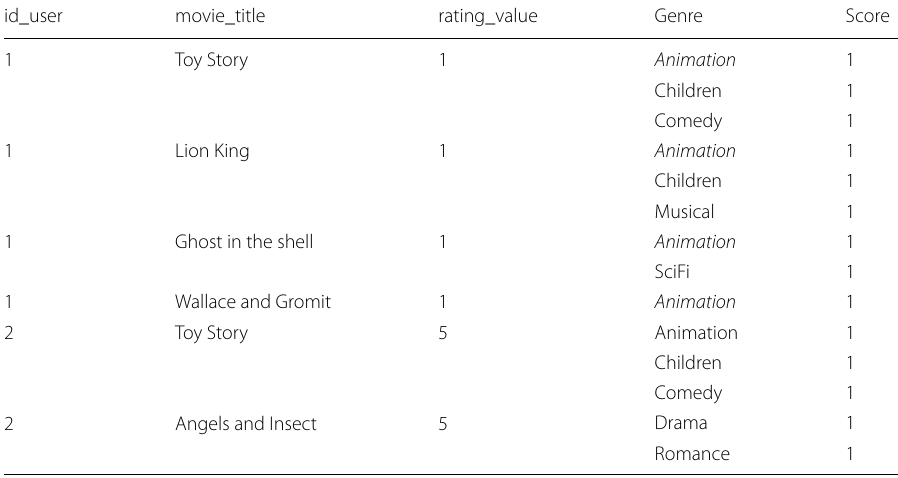
Table 3 Summary of movie data and rating